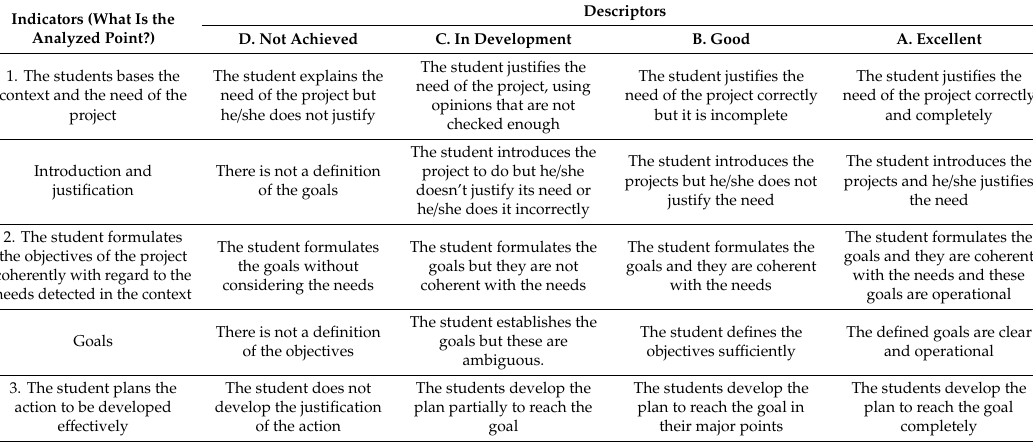
Table A1. Specific indicators used to evaluate hydraulic